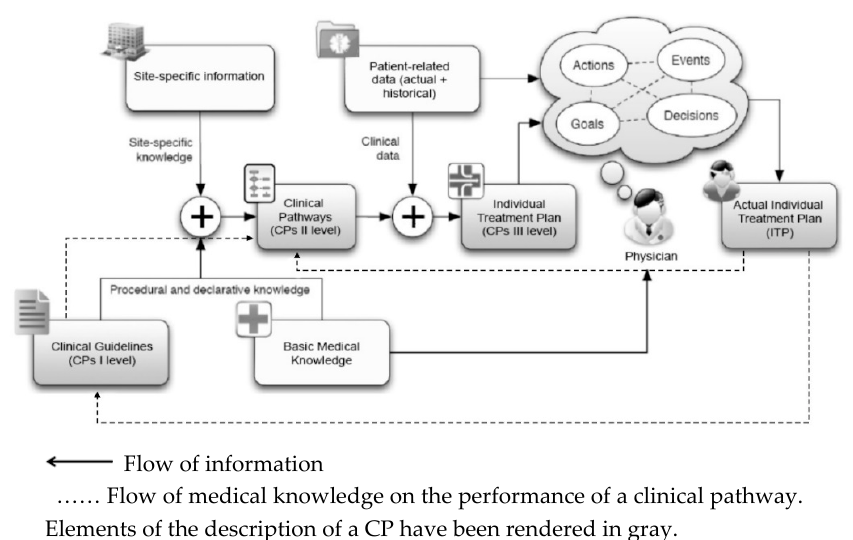
Figure 2. The flow of information from Clinical Guidelines (first level CPs) to the actual Individual Treatment Plan (third level